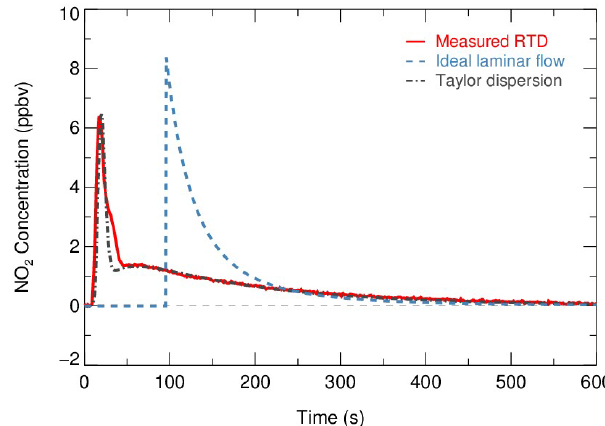
Figure 8. Residence time distribution derived by sampling NO 2 gas. Red solid line indicates the measured RTD profiles. The cal- culated RTD of ideal laminar flow (without dispersions) and the Taylor dispersion model fitted to measurements are shown as a blue dashed line and dot-dash line,